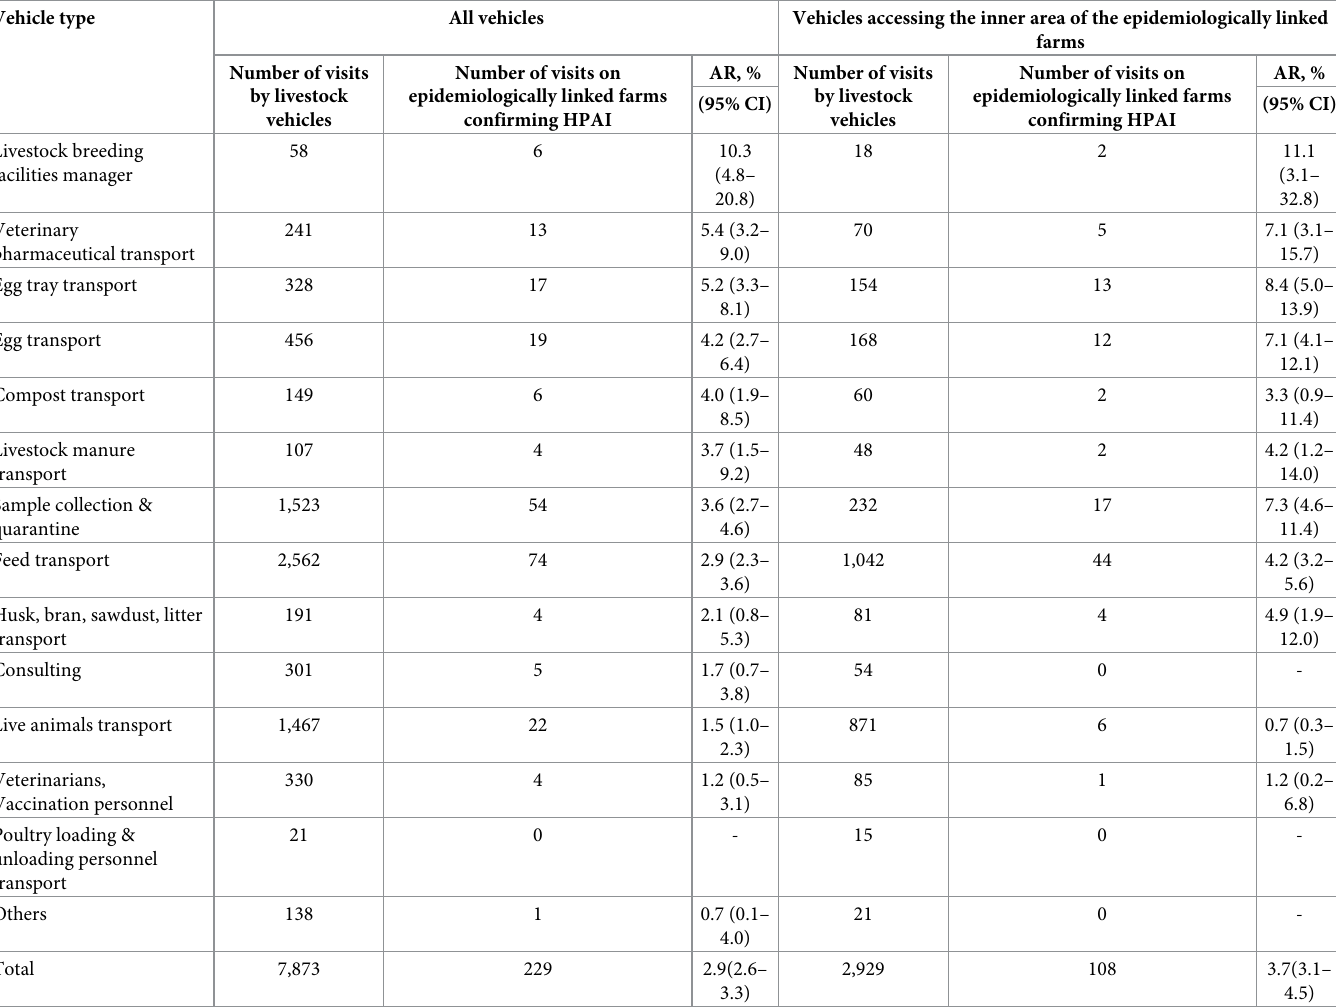
Table 4. Number of visits by livestock vehicles on the epidemiologically linked farms and Attack Rate (AR) by vehicle type. Vehicle